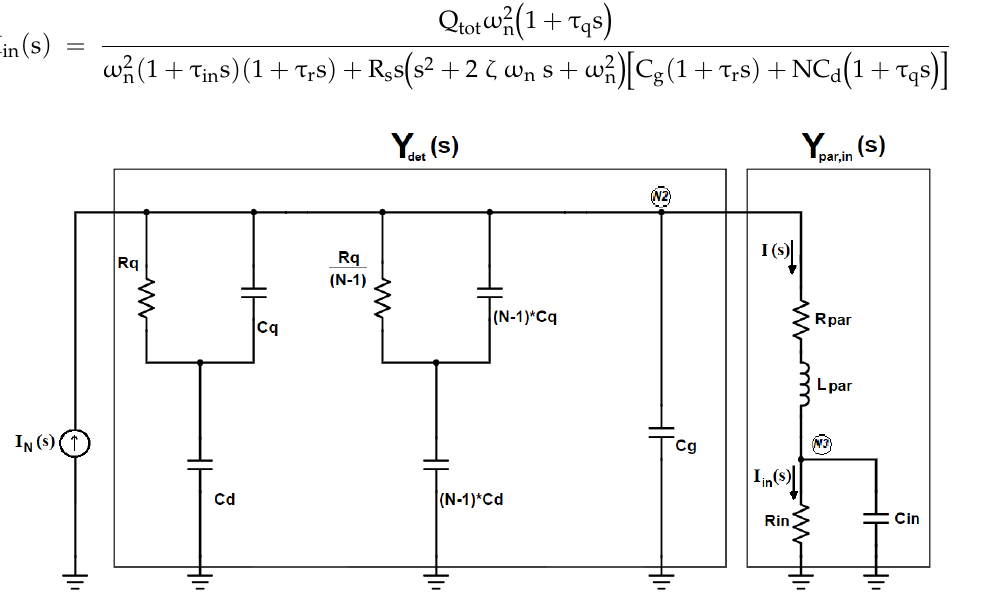
Figure 2. The input section of the circuit in Figure 1, redrawn as the parallel of two admittances, Y det and Y par,in .